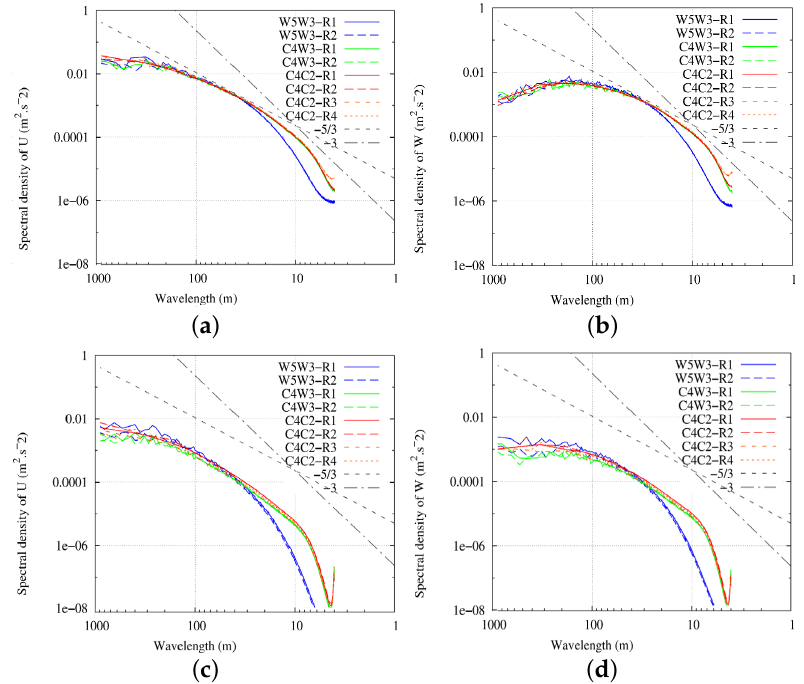
Figure 5. Spectral density ( a , b ) in the boundary layer up to 200 m; ( c , d ) in the highest levels 200 m < z < 800 m. ( a ) and ( c ) present the discrete Fourier transform (DFT) of the zonal wind component, ( b ) and ( d ) the DFT of the vertical wind component. The colour code indicates the advection scheme and the line type of the run depending on the